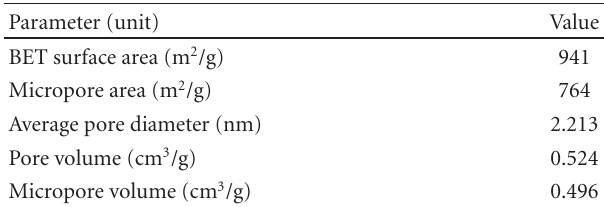
Table 1: Results of BET test for PSAC